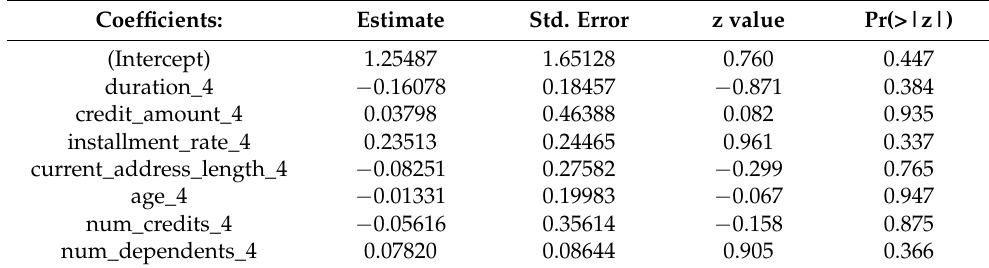
Table 6. Coefficients and statistics of model